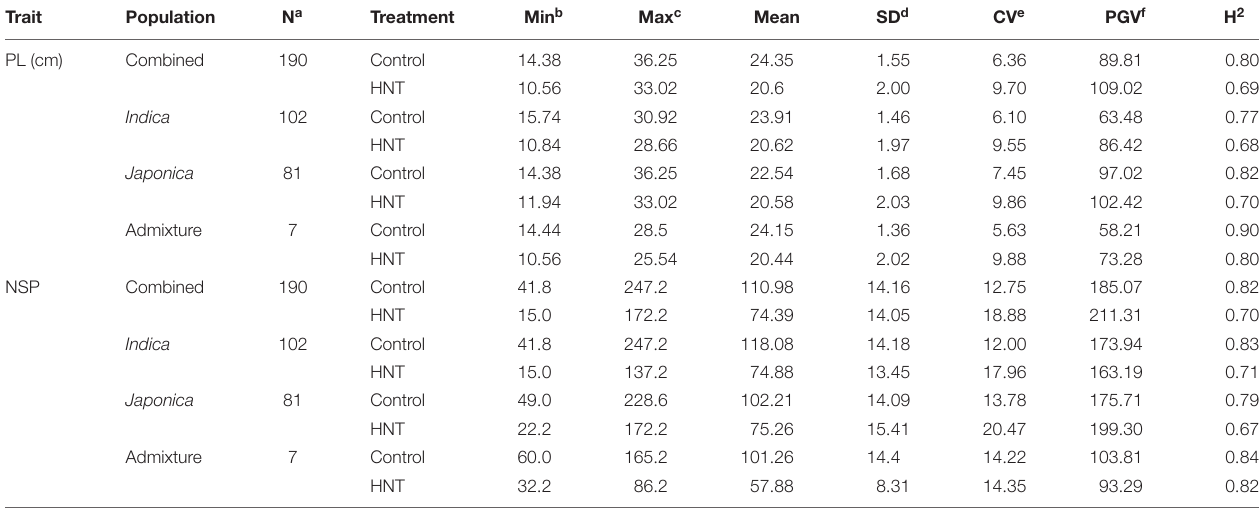
TABLE 1 | Natural variation and broad sense heritability (H 2 ) in the panel of 190 diverse rice accessions of the USDA rice mini-core collection (URMC) comprising Combined, Indica , Japonica , and Admixture populations for panicle length (PL-cm) and number of spikelets per panicle (NSP) under high nighttime temperature (HNT) stress and control treatments.